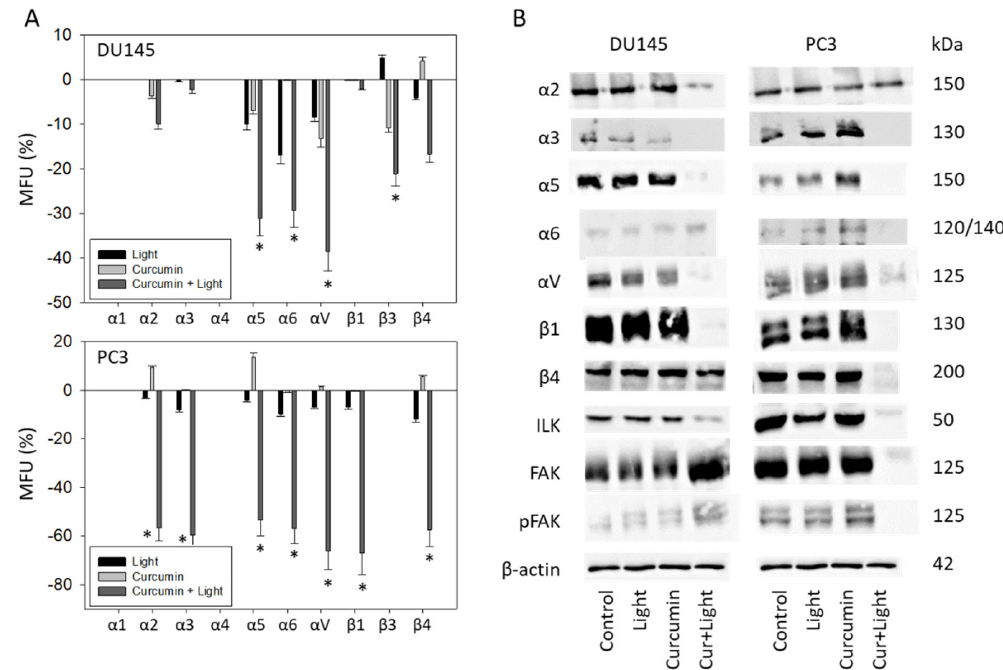
Figure 8. ( A ): Expression level of integrin α and β subtypes following visible light (5 min at 1.65 J/cm 2 ), curcumin (0.2 µ g/mL), or curcumin + light exposure. The upper panel depicts integrin expression for DU145 cells, the lower panel for PC3 cells. All values are related to untreated controls set to 100%. Means ± SD of n = 4; error bars indicate standard deviation; * indicates significant difference to corresponding control. ( B ): Integrin α and β , ILK and FAK protein analysis in DU145 and PC3 cells after exposure to light, curcumin, or curcumin + light combination (Cur + light). β -actin served as internal control. One representative of three separate experiments is shown. Controls remained untreated.